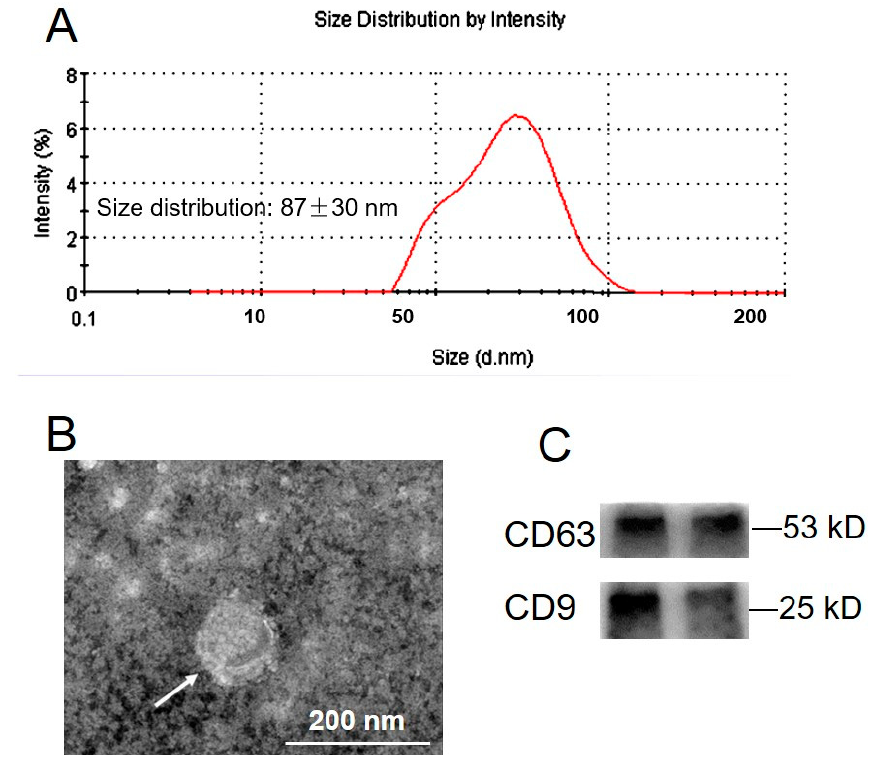
Figure 1. Isolation and characterization of exosomes derived from sow plasma. ( A ) Nanoparticle tracking analysis (NTA) of size distributions of exosomes. ( B ) Morphology of exosomes under transmission electron microscopy. ( C ) Western blotting was performed to detect the expression of exosomal markers CD63 and CD9 in plasma-derived exosomes.